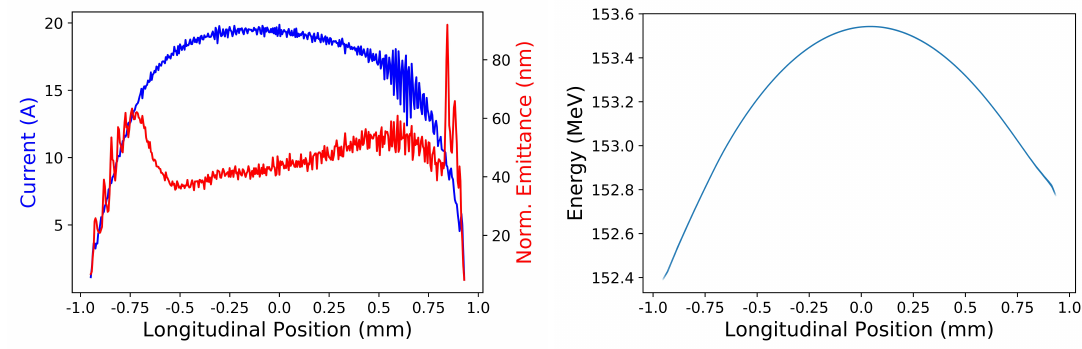
Figure 1. Input beam phase space from the TOPGUN design. On the left, the current profile is plotted in blue along with, in red, the slice normalized emittance. On the right, the longitudinal phase space is shown. In both plots, the beam head is to the